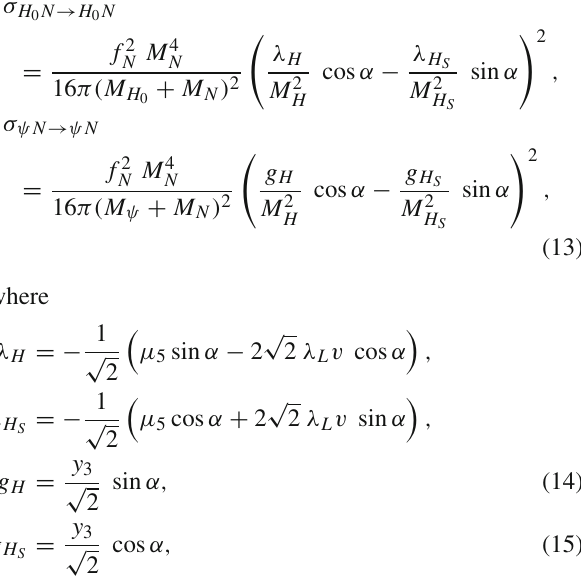
to the T -parameter given